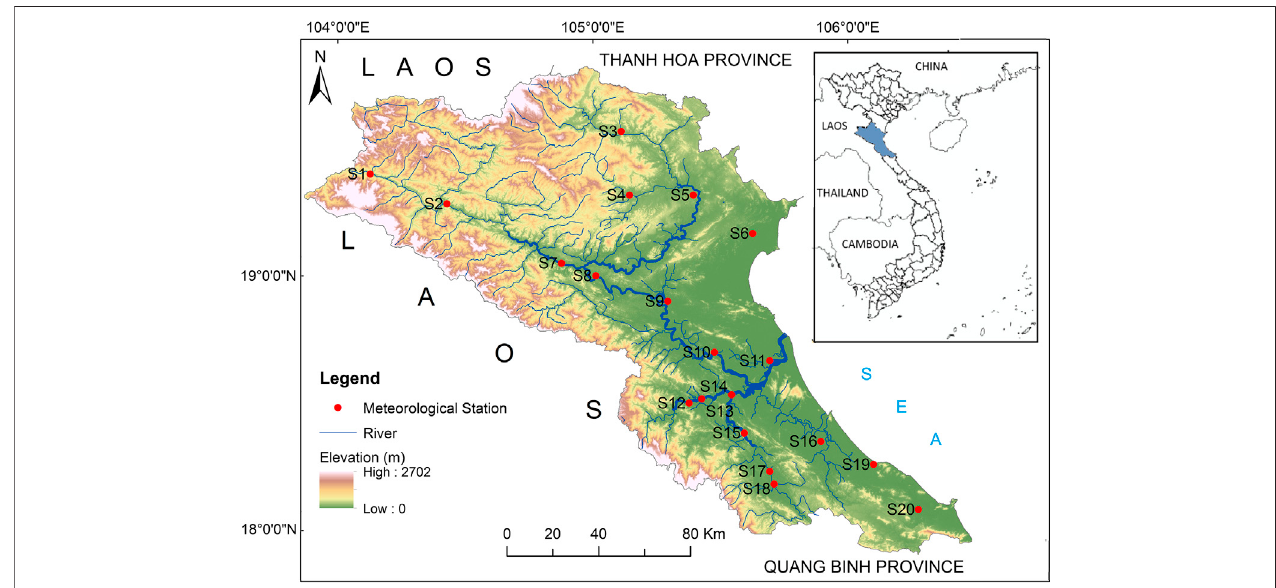
FIGURE 1 | Geographic location of the LCRB and meteorological stations in the